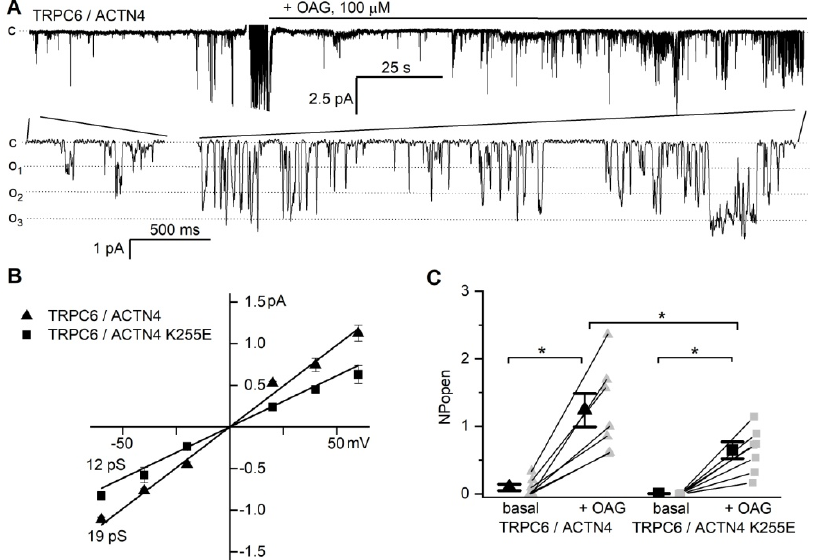
Figure 5. Activities of TRPC6 channels in response to OAG in CHO cells co-transfected with wild type ACTN4 ( α -actinin-4) or ACTN4 K255E. ( A ) Typical trace of OAG-induced TRPC6 activity in CHO cells co-transfected with ACTN4; (c) and (o i ) denote closed and open states of the channel, respectively; a full recording (upper row) and fragments of a recording at a larger scale are shown.